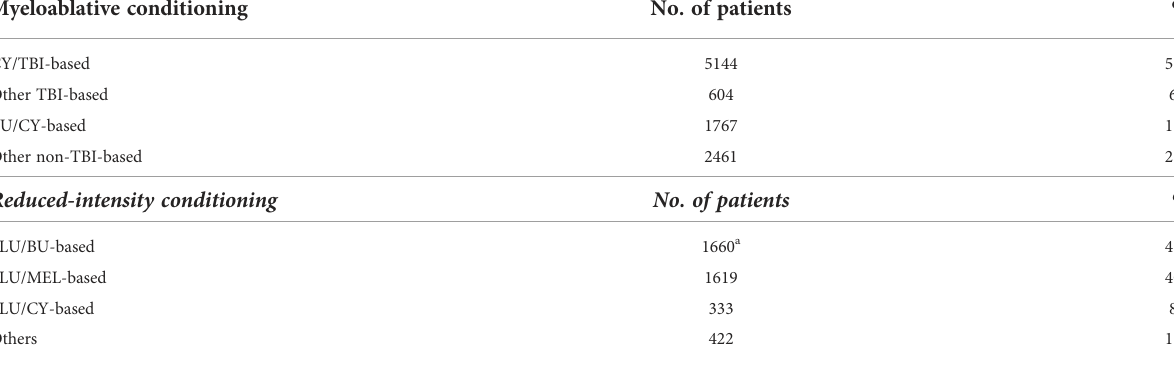
TABLE 1 Distribution of conditioning regimens for adults with AML undergoing allogeneic HCT during the period 1992 to 2016 in Japan. Myeloablative